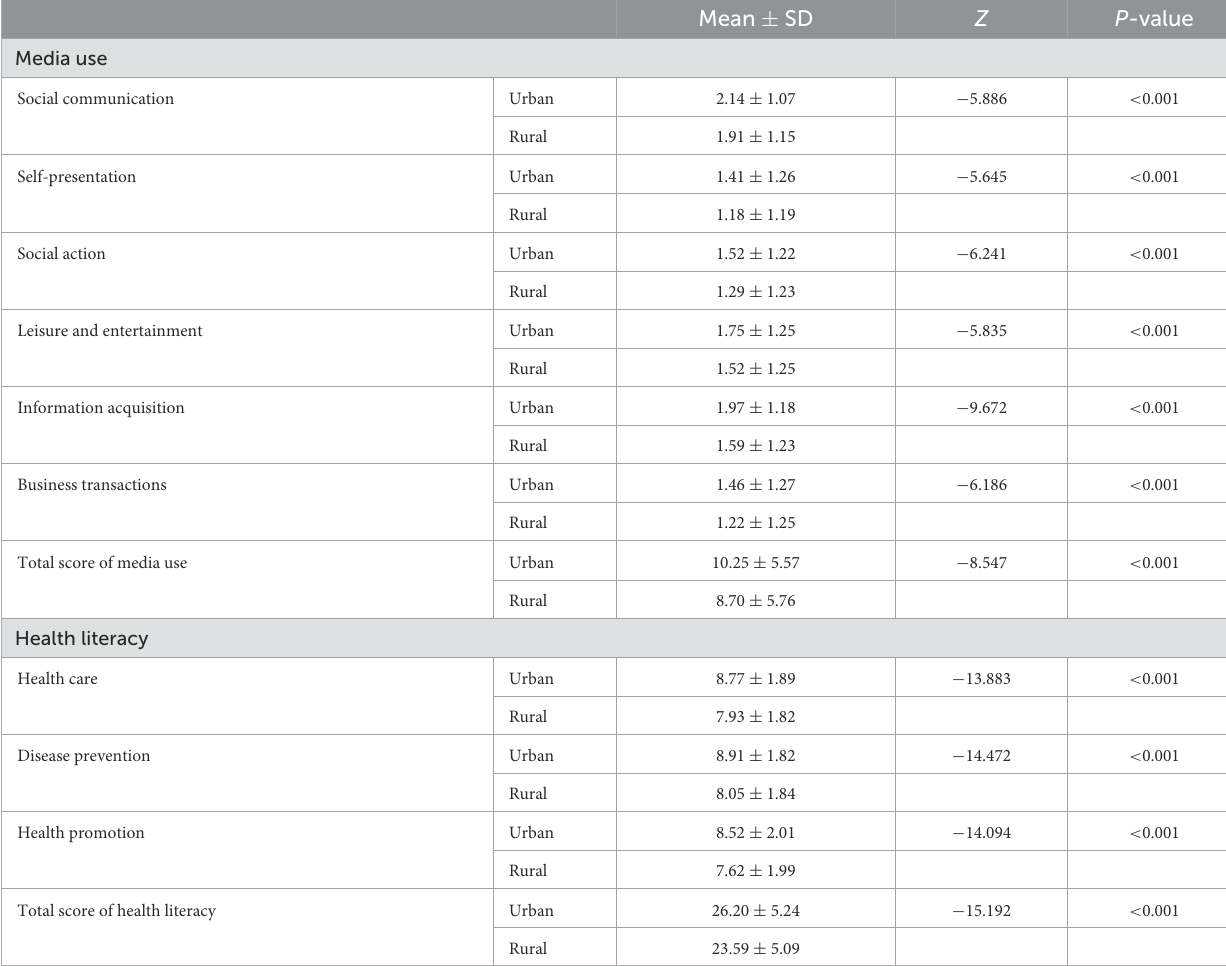
TABLE 2 The difference in media use and health literacy between urban ( N = 2,276) and rural ( N = 1,794) elderly in China.